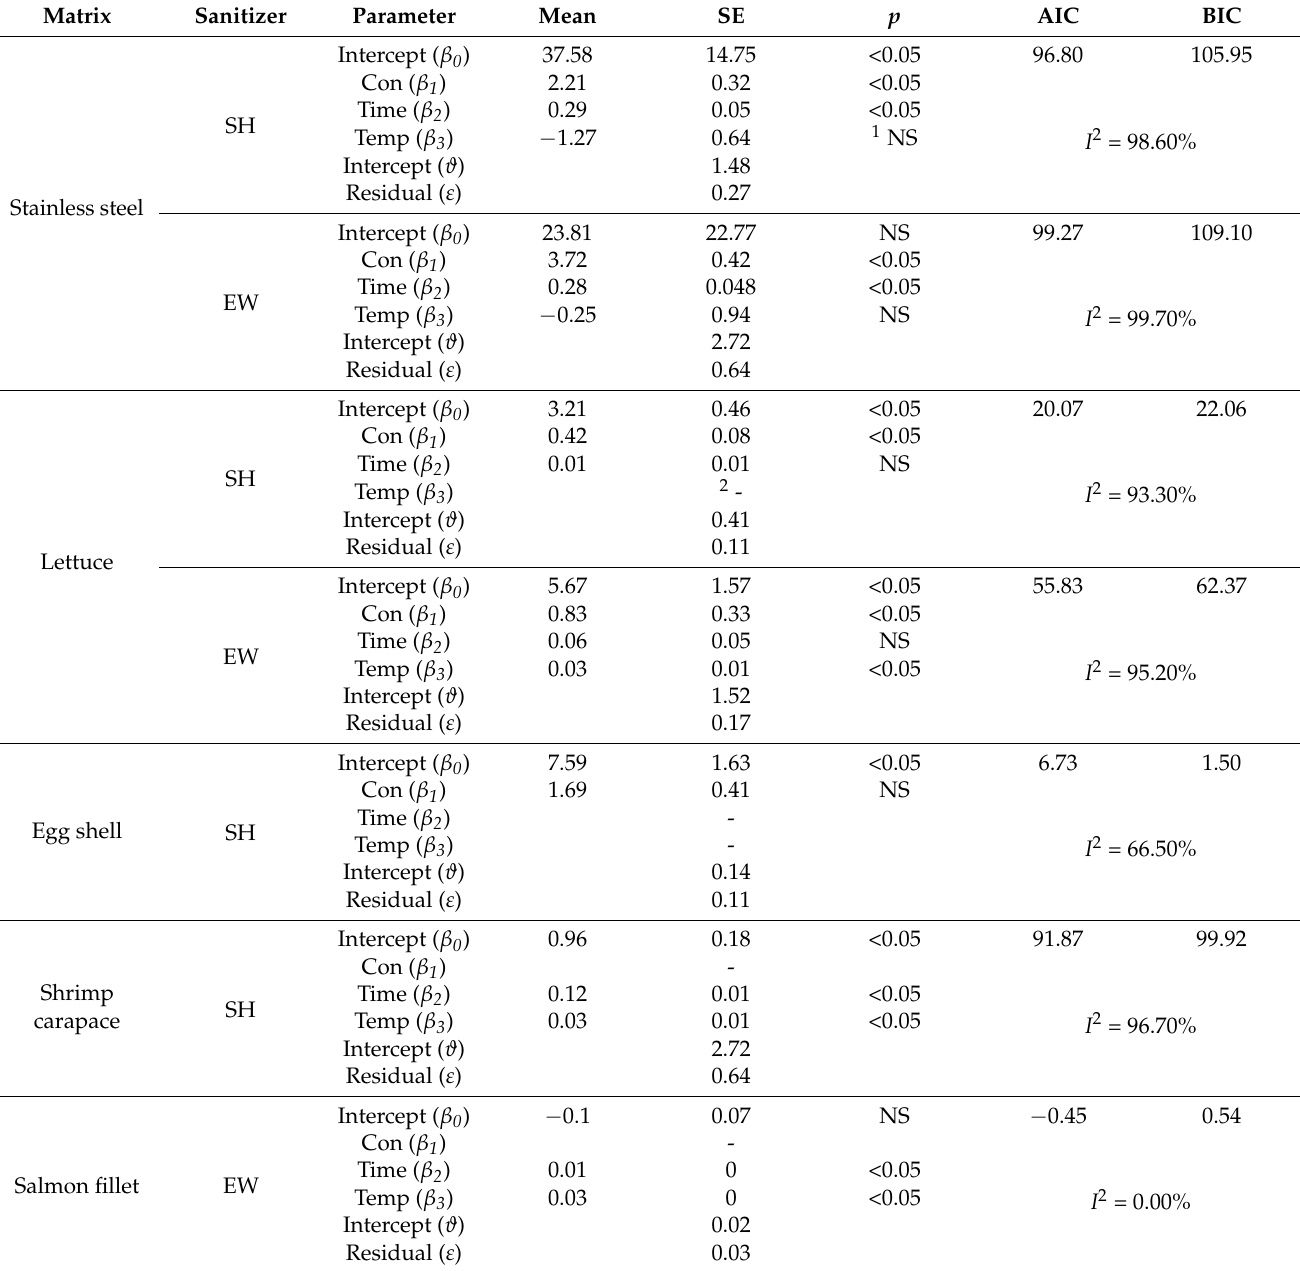
Table 3. Estimated parameters of the mixed-effects models by